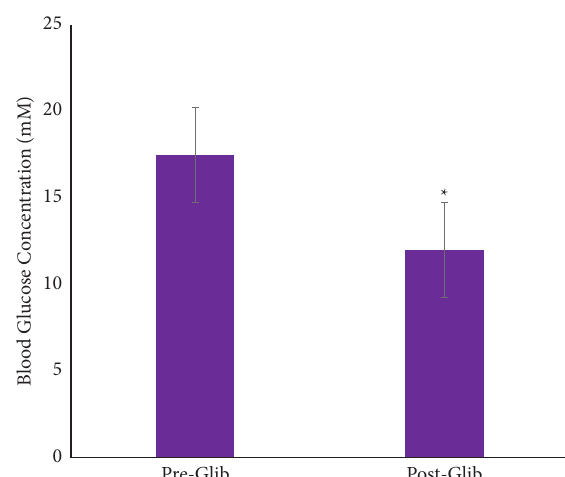
Figure 1: Antidiabetic drug response test of diabetic animals used in the study, where ∗ indicates a statistically significant difference when compared with preglibenclamide administration.